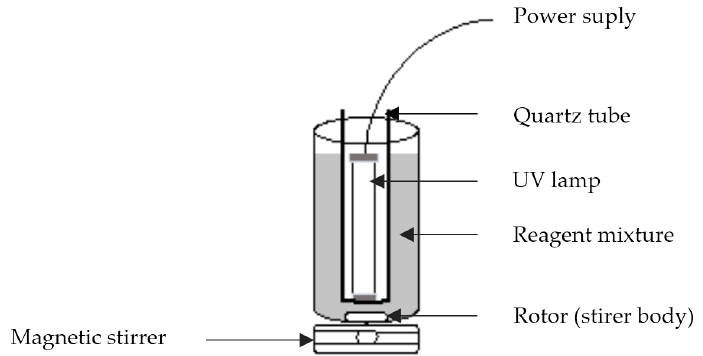
Figure 2. Schematic diagram of photochemical reaction device.